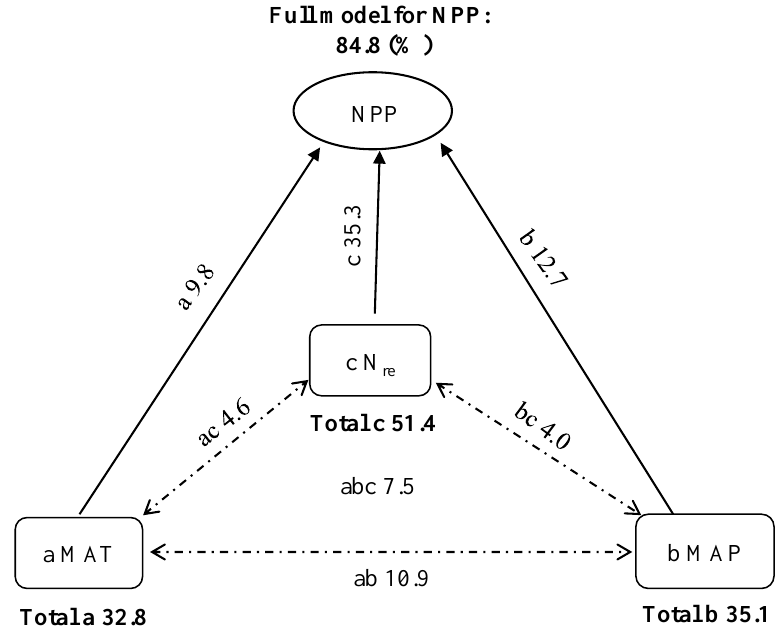
Figure 5. Summary of the partial general linear model (partial GLM) for the effects of mean annual temperature (MAT), mean annual precipitation (MAP), and annual litter N (N re ) on net primary productivity (NPP). In the partial GLM, a, b, and c denoted the independent effects of MAT, MAP and N re , respectively; ab, ac, and bc indicated respectively the interactive effects between MAT and MAP, MAT, and N re , MAP and N re ; and abc represented the interactive effects of the three different factors.